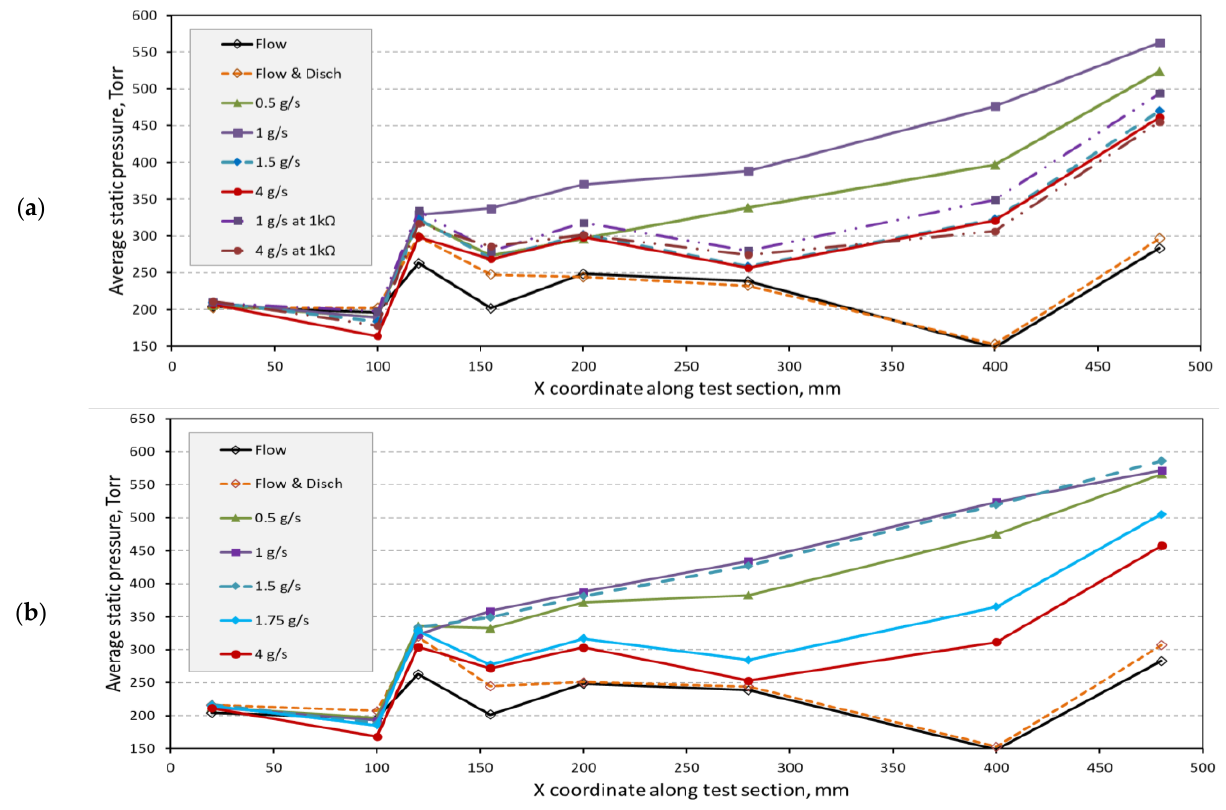
Figure 3. Static pressure distribution for pylon ver.a in the case of ballast resistance of ( a ) 750 and 1 k Ω; and ( b ) 500 Ω. The pylon is located between 50 and 80 mm, and the ends of the electrodes are located at 110 mm.